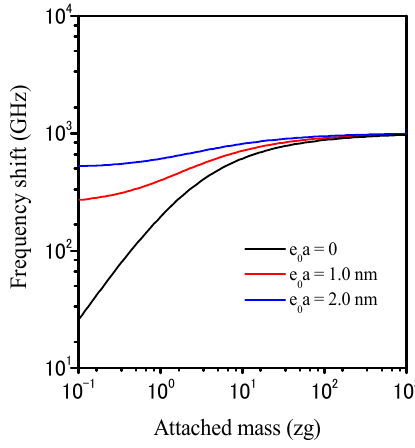
2ℎ = (cid:1838) 2ℎ = 20, (cid:2022) = (cid:2015) = 0.5⁄⁄ ). (cid:3028) (cid:3029)